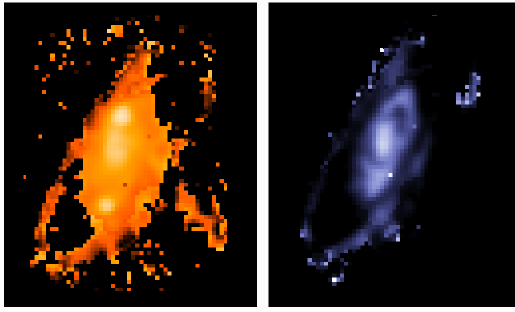
Figure 3: NGC 4258 Temperature (left) and dust mass (right). The spatial distribution of dust mass